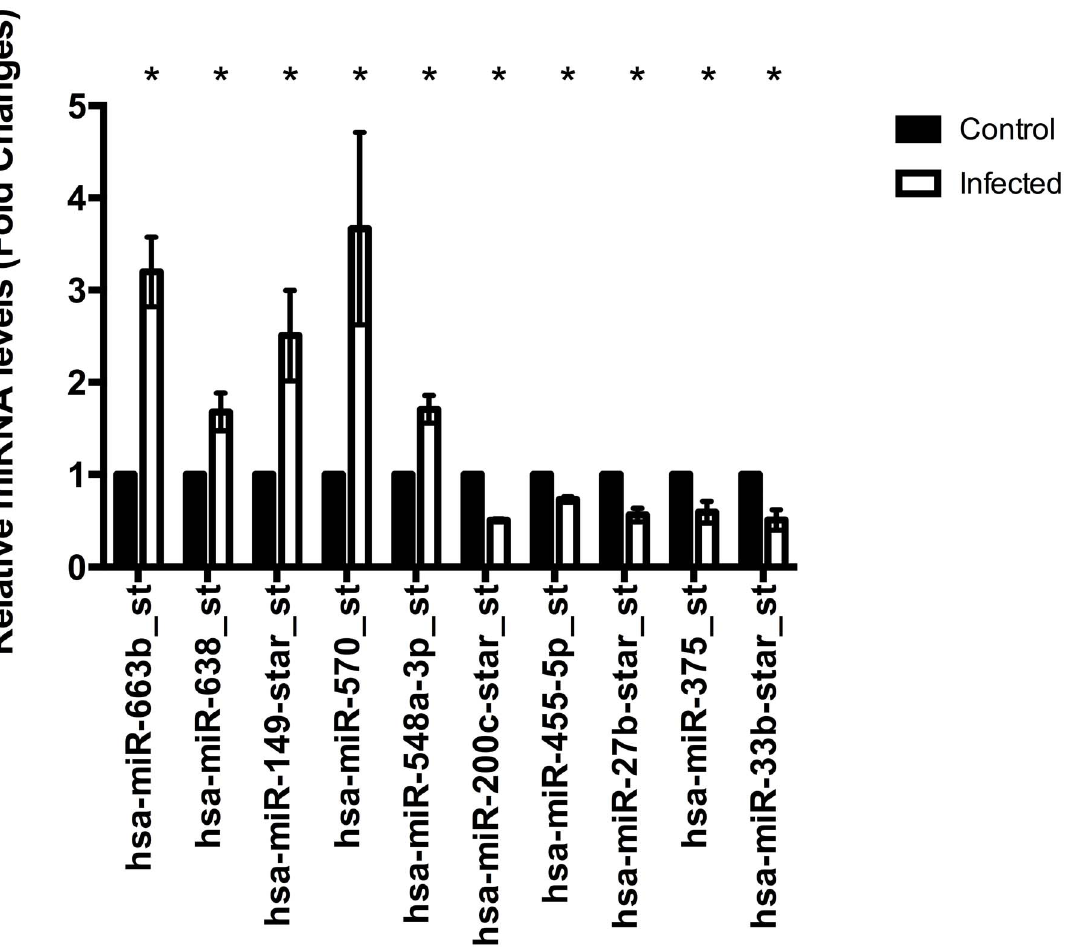
Figure 5. Validation of differential expression of selected miRNAs by qPCR. Ten expression levels of selected miRNAs from microarray assay were validated using qPCR. U6snRNA was used as reference RNA for the normalization of miRNAs and relative gene expression was quantified based on 2 2 DD CT . (n=3, *=p values of , 0.05).